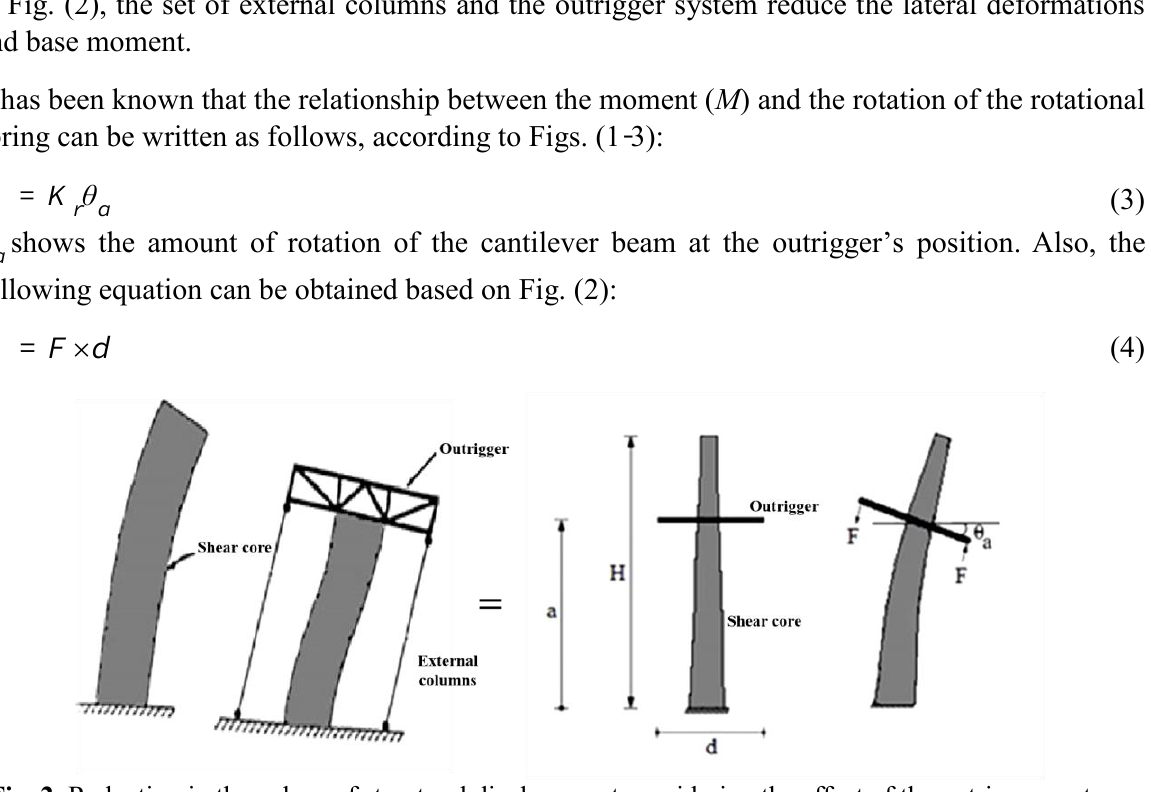
Fig. 2. Reduction in the values of structural displacement considering the effect of the outrigger